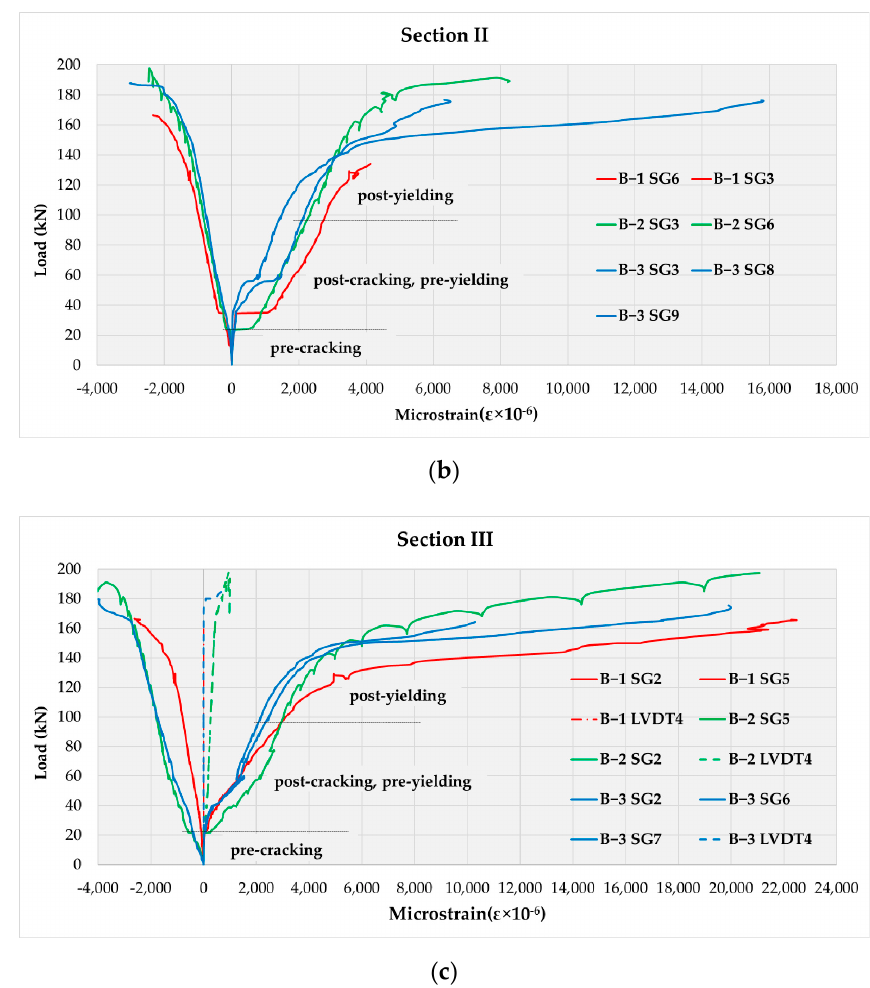
Figure 5. Load vs. strain curves for concrete and tensioned reinforcement for: ( a ) Section I; ( b ) Section II; ( c ) Section III.